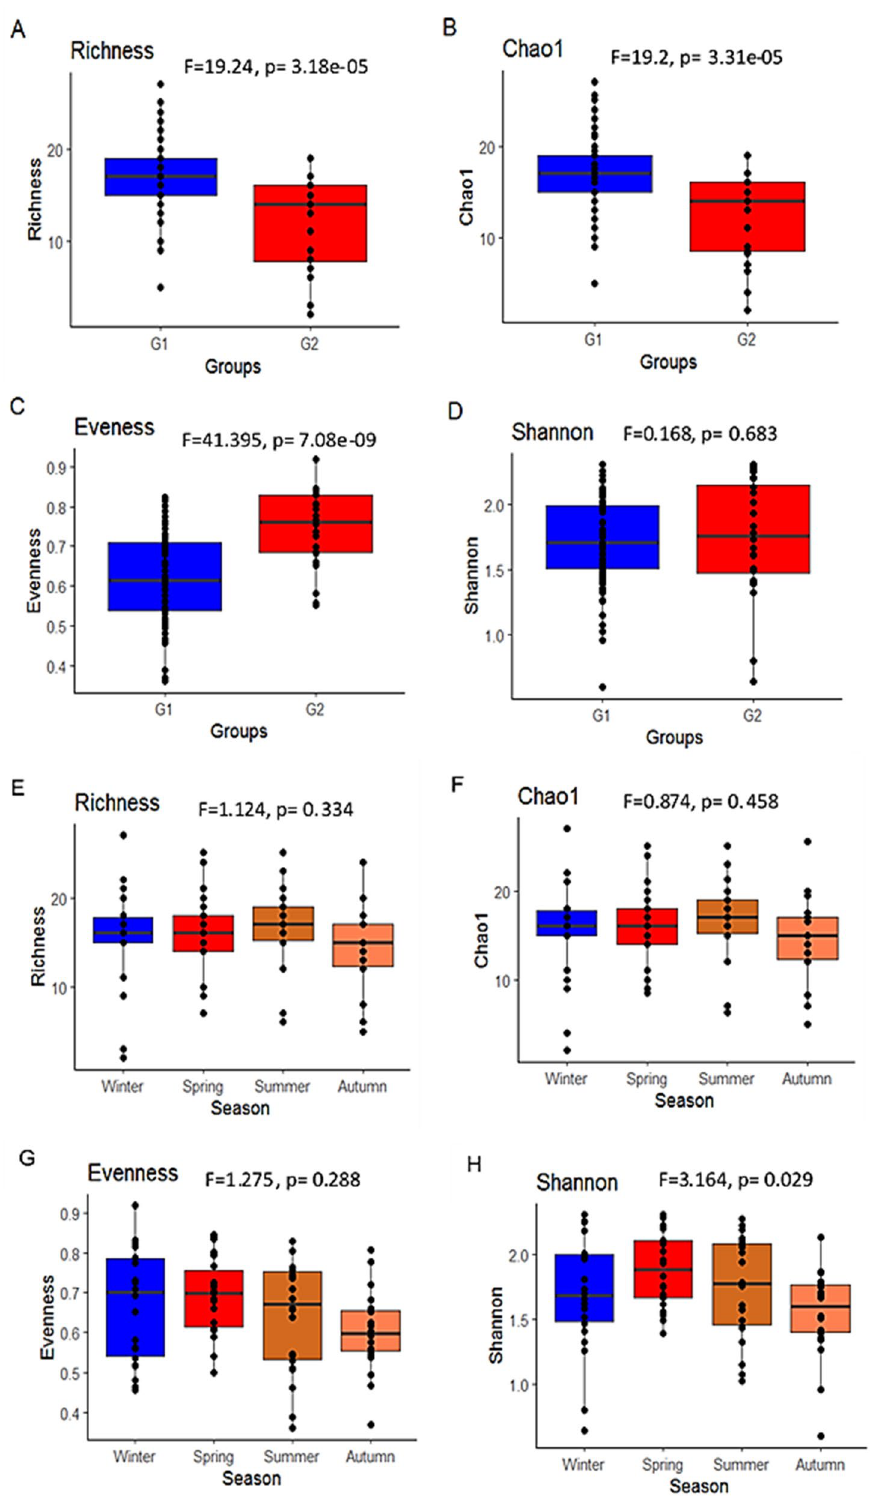
Figure 6. Showing variation in species richness, Chao1, and Evenness metrics among seasons and